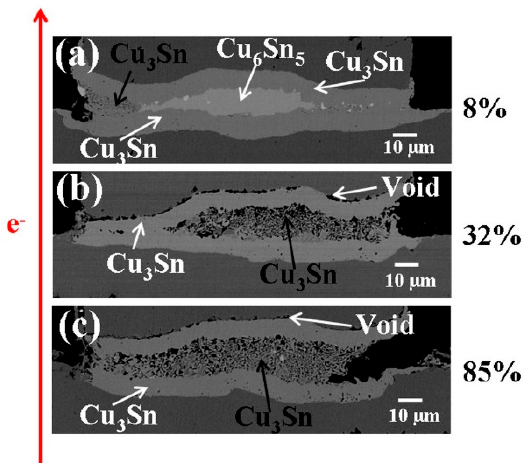
Figure 3. Cross-sectional SEM images of solder bumps with Cu column UBM stressed at 1.45 × 10 4 A/cm 2 with upward electron flow at 185 °C with bump resistance increases ( a ) 8%, ( b ) 32%, and ( c ) 85% of its initial value.